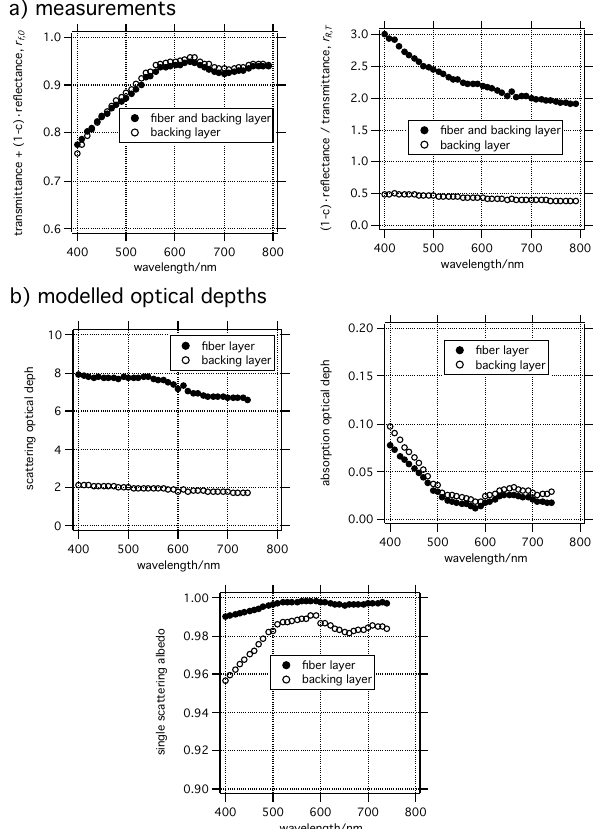
Figure 5. (a) Measured sums and ratios of reflectance and transmit- tance for the total filter and the backing layer. (b) Modeled scatter- ing and absorption optical depths, as well as single-scattering albe- dos, for the fiber and backing